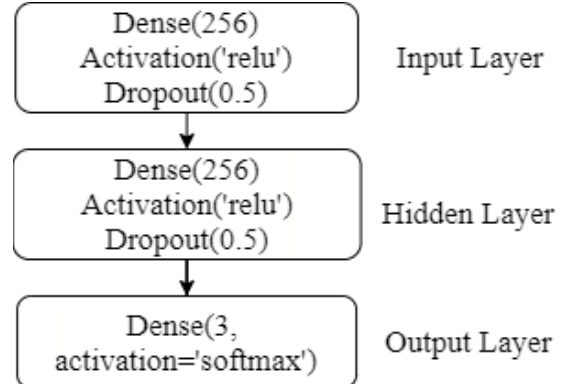
Figure 10. Architecture of MLP model designed for this study. Dense refers to a fully connected layer, activation is the activation function used while the dropout layer shows the neural dropout ratio used for optimization.